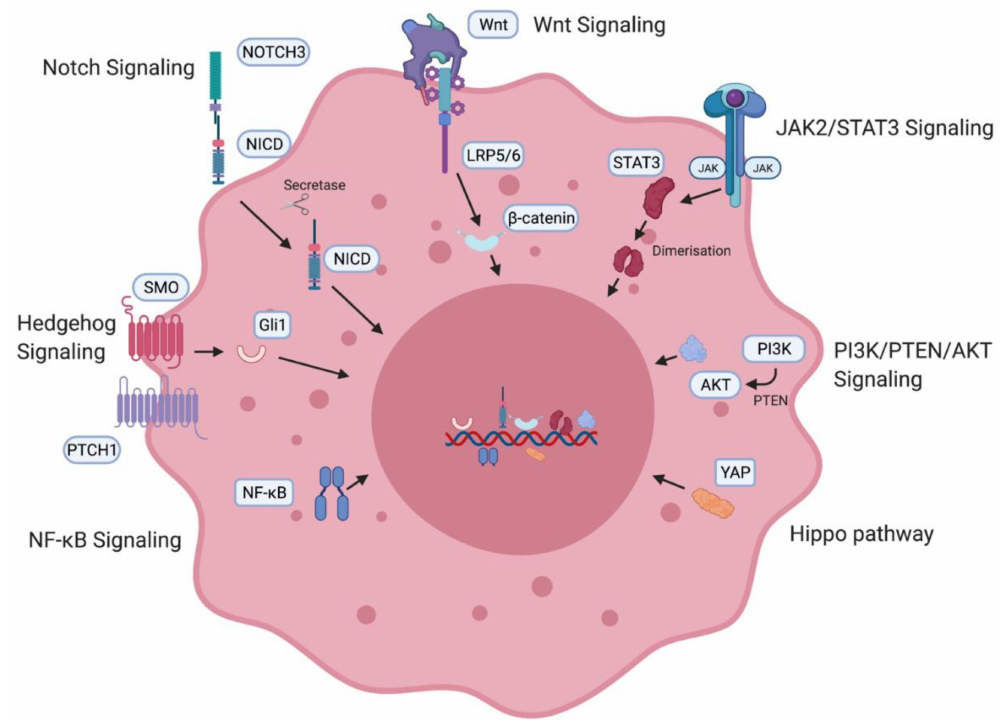
Figure 3. Ovarian cancer stem cell (OCSC)-associated signaling pathways. OCSC signaling pathways involved in the generation and maintenance of OCSCs including the Notch pathway [10,11], Wnt signaling pathway [10,11], JAK2/STAT3 pathway [12–14], PI3K/PTEN/AKT pathway [15], Hippo pathway [16], NF- κ B [17,18] and the Hedgehog pathway [19]. NICD—intracellular domain of Notch protein; LRP—low-density lipoprotein-related protein; JAK—Janus kinase, STAT— signal transducer and activator of transcription proteins; PI3K—phosphatidylinositol 3-kinase, PTEN—phosphatidylinositol 3,4,5—triphosphate 3-phosphatase, AKT/PKB—protein kinase B; YAP—Yes-associated protein; NF- κ B—nuclear factor kappa